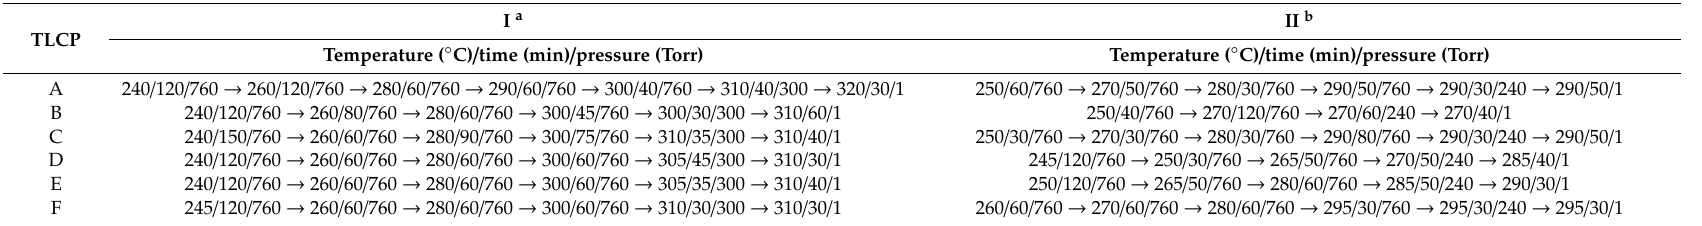
Table 2. Melt polymerization conditions of TLCPs.